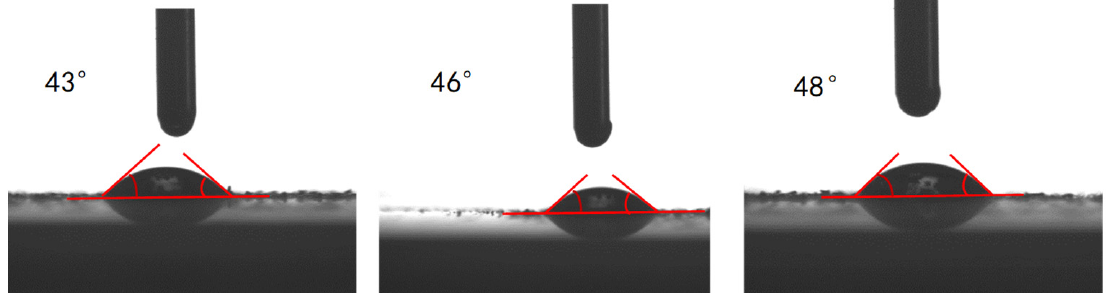
Figure 2. Static water contact angle results for the MOF.